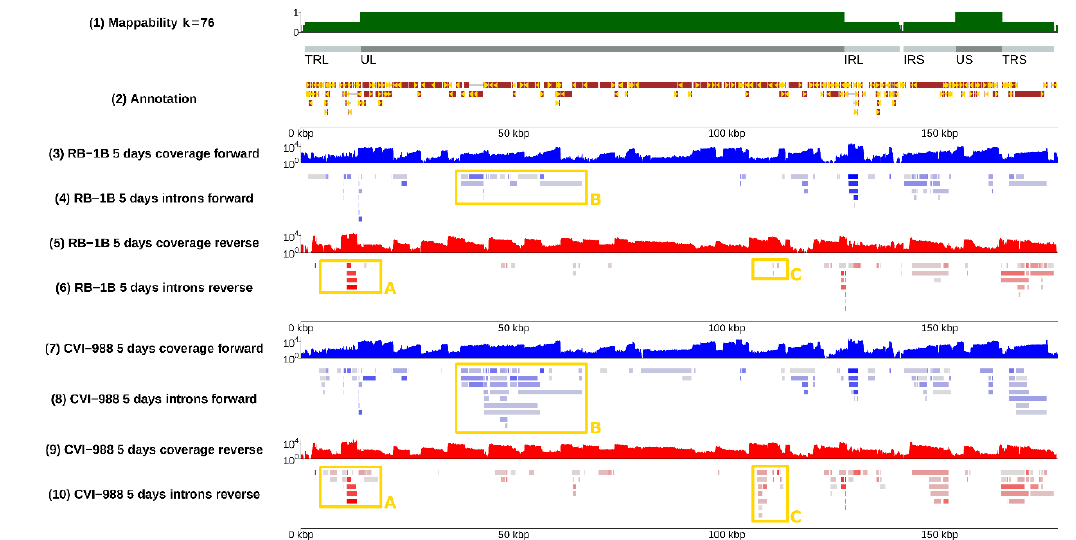
Figure 1. The splicing landscape of Marek’s disease virus (MDV)-infected chicken embryo fibroblast (CEF) cells. An overview of splicing in CEF cells infected with two strains of MDV at 5 days post-infection. Results are presented as a genome browser, each numbered label on the left corresponding to a different track on the right. Track (1) (green) shows mappability—computed as in [22]—for all 76-mers in the MDV genome, which matched the read length of our RNA-sequencing experiment. Areas having mappability 1 corresponded to unique regions, whereas areas having mappability 0.5 corresponded to parts of the genome repeated twice. Track (2) (brown) shows the position of the open reading frames originally annotated by Tulman and colleagues [37–39] plus a few additional transcripts published more recently; gene nomenclature was omitted to reduce clutter. Blue profile tracks (3) and (7) show the coverage of directional RNA-Seq along the forward strand in different biological conditions – infection with MDV strain RB-1B for track (3), and infection with MDV strain CVI-988 for track (7). Red tracks (5) and (9) show the corresponding coverage along the reverse strand of the virus. Tracks (4), (6), (8), and (10) show observed introns, as deduced from coverage in spliced reads. The degree of coverage of an intron corresponds to how coloured it is with respect to its grey background. Introns tracks are also directional (forward and reverse), and to each coverage track, there corresponds an intron track (see labels). Placement of an intron in the inverted repeats – terminal repeat long (TRL) vs. internal repeat long (IRL) or internal repeat short (IRS) vs. terminal repeat short (TRS) – was done arbitrarily. There are several regions of the genome showing substantially different splicing patterns for the RB-1B and CVI-988 strains. Splice junctions of interest within such regions are highlighted with yellow frames. Frame A is magnified in Figure 2; frame B in Figure 3; frame C in Figure 4. This figure can be reproduced in the online MDV genome browser by accessing https://mallorn.pirbright.ac.uk/browsers/MDV-annotation/Figure-1.html.